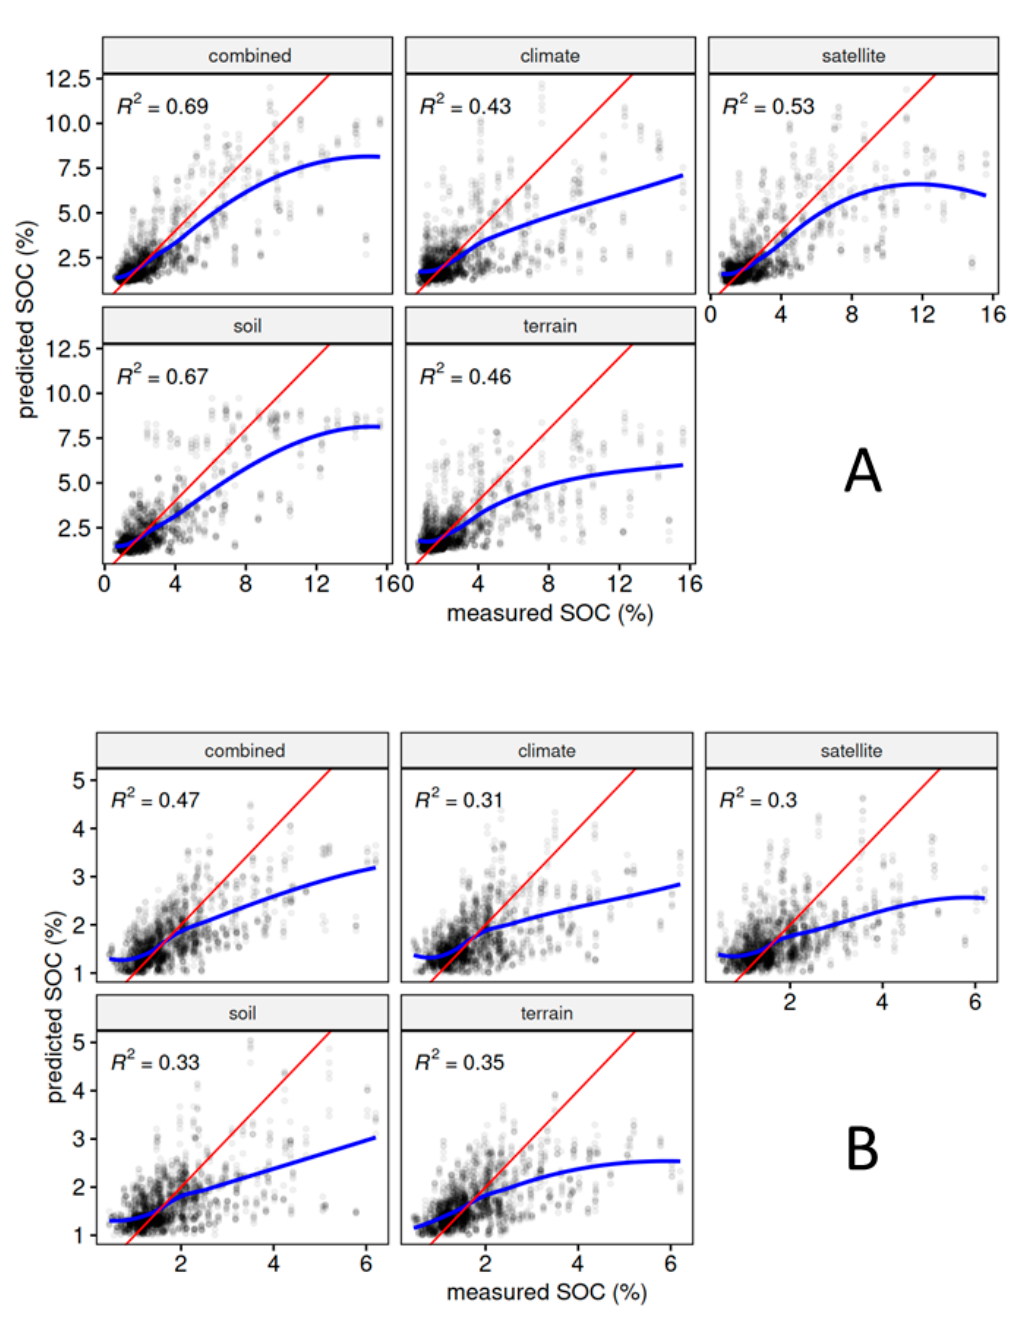
Figure 4. Scatter plot and LOESS-function (blue) of the predicted and measured SOC values in BY ( A ) and BW ( B ). R 2 values were calculated based on all cross-validation results (6 times 10). 1:1 lines are displayed in red.